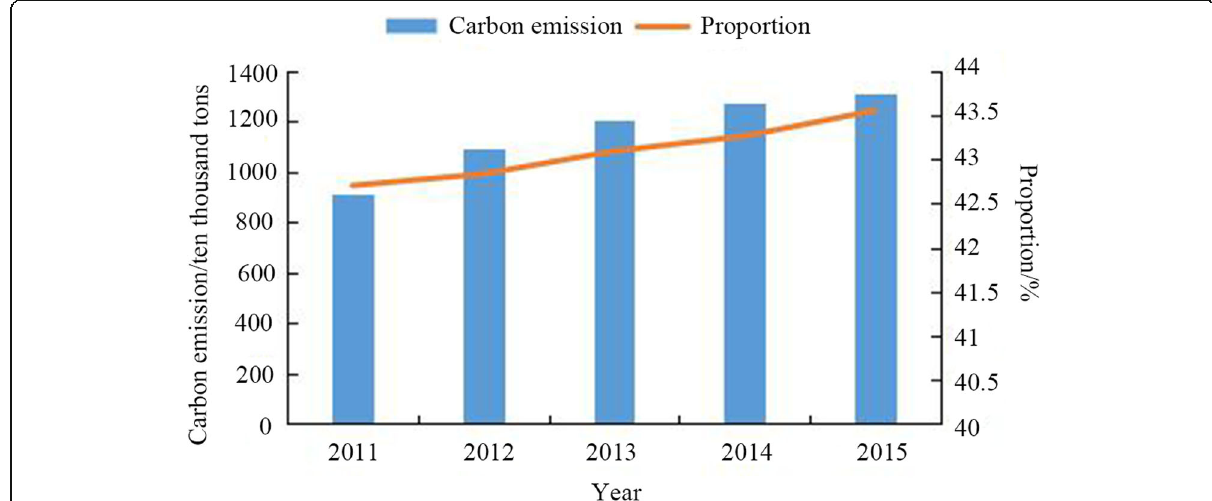
Fig. 2 Changes of carbon emissions of tourism transportation, storage, and postal